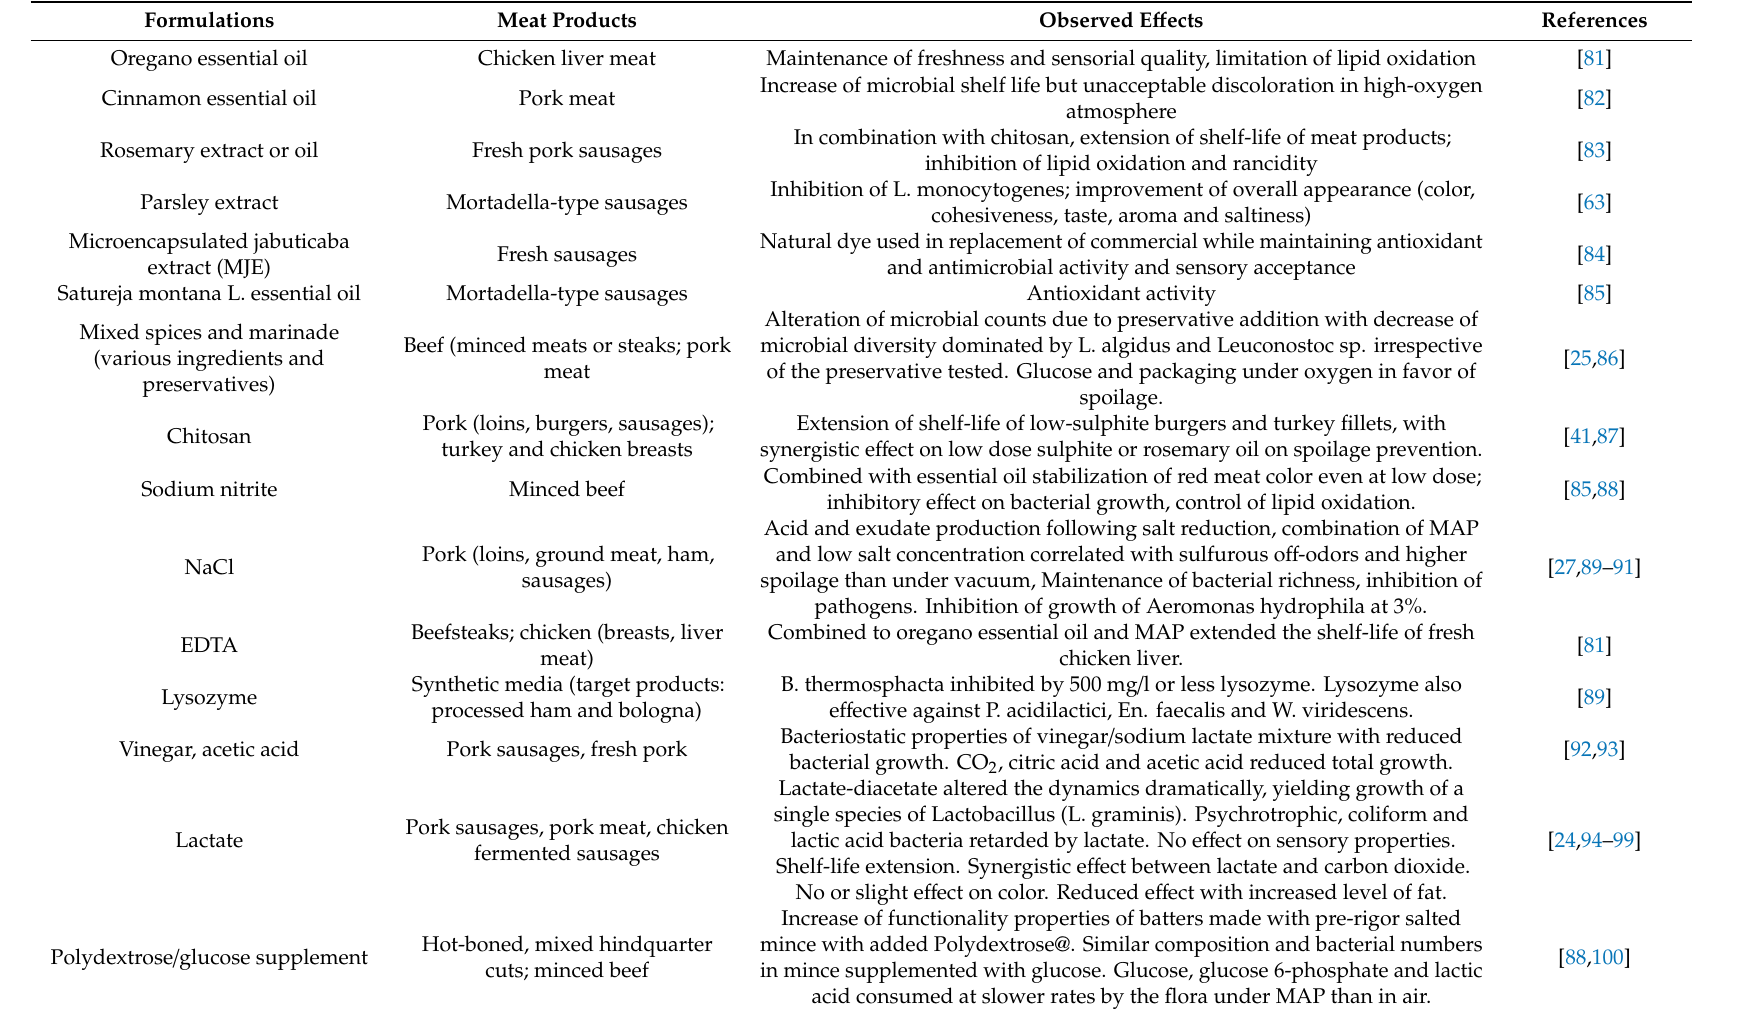
Table 1. Application of formulation for preserving fresh meat and processed meat